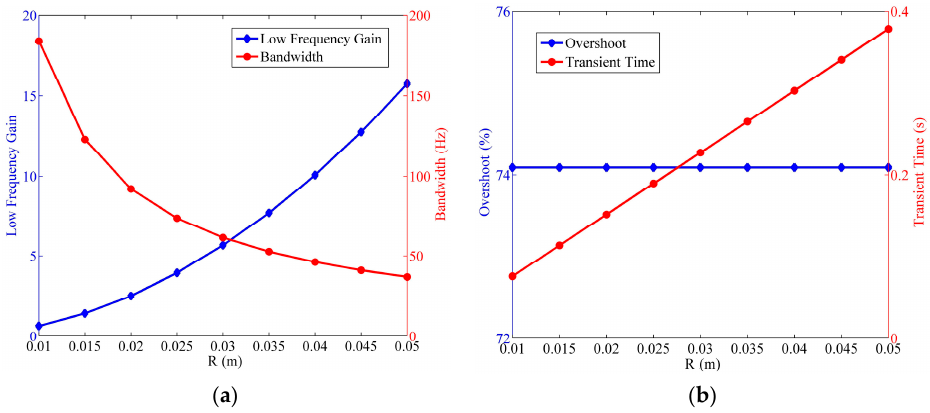
Figure 17. Relationship of the fluidic system indexes versus the radius of the circular tube, where R h = 2 × 10 10 Ns/m 5 , a = 20 m/s, r = 4 mm. ( a ) Variation of the low frequency gain and the bandwidth; ( b ) variation of the step response overshoot and the transient time.